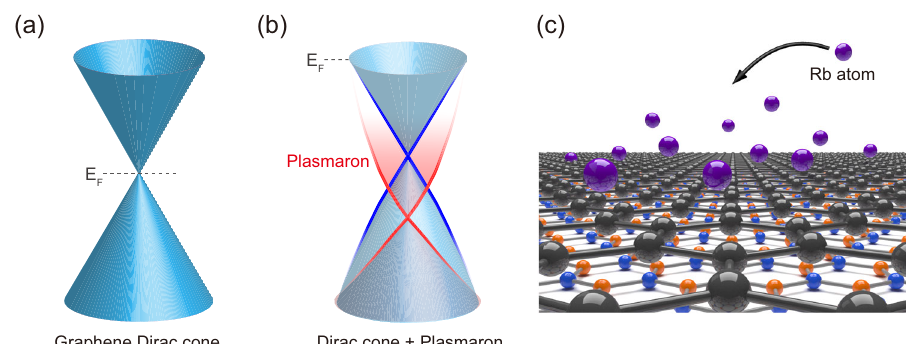
Fig. 1 A schematic drawing for plasmarons in highly electron-doped graphene/h-BN heterostructure. a Dirac cone dispersion in undoped sample. b Plasmaron bands plus Dirac cone in highly electron-doped graphene/h-BN. Blue and red cones represent the graphene Dirac cone and plasmaron bands respectively. c A schematic drawing of electron doping of graphene/h-BN heterostructure by in situ Rb